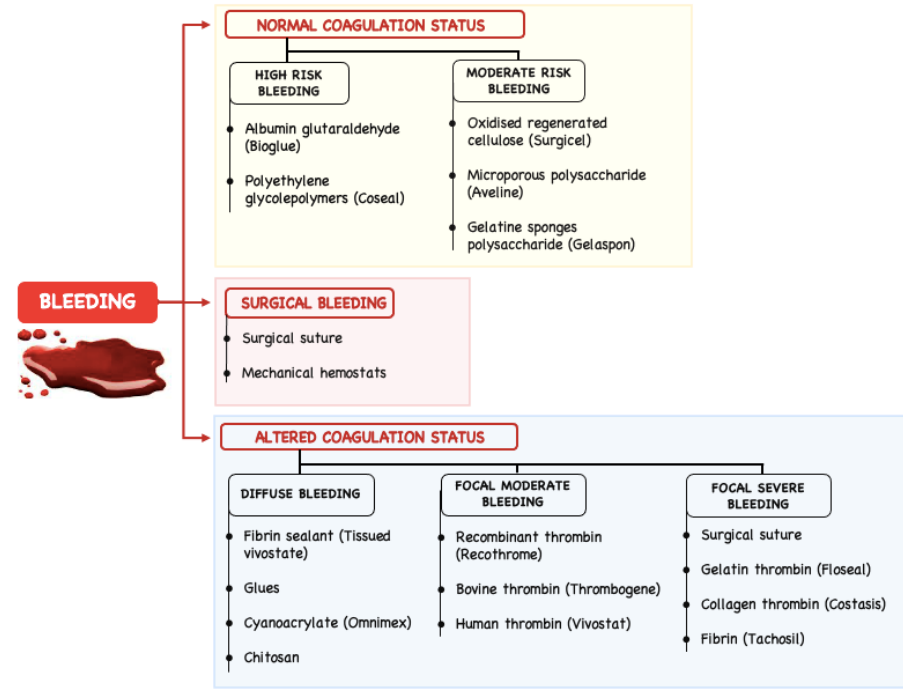
Figure 2. Bleeding management using haemostatic agents.